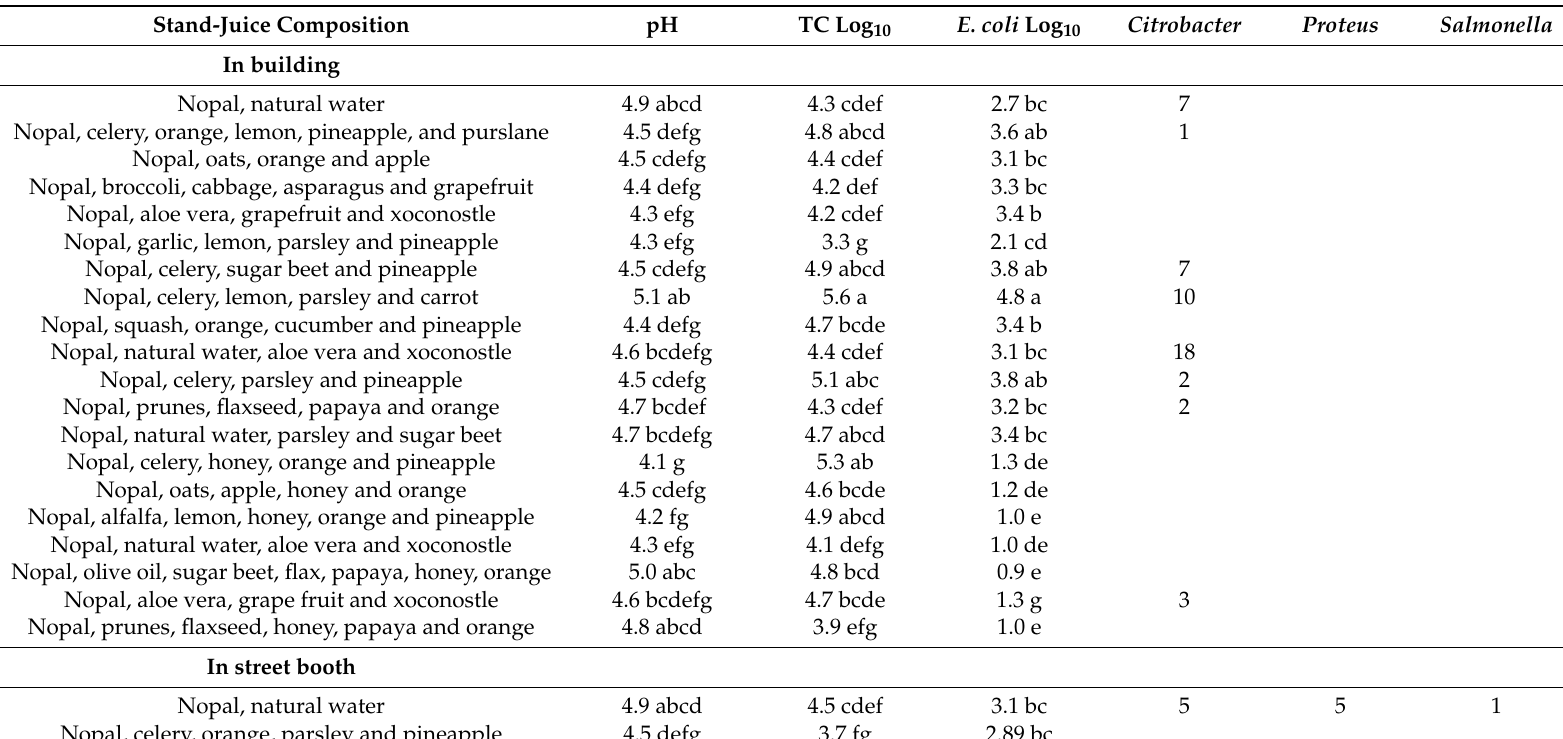
Table 2. Incidence of coliforms and number of enteropathogen isolates in nopal juices. Stand-Juice Composition pH TC Log 10 E. coli Log 10 Citrobacter Proteus